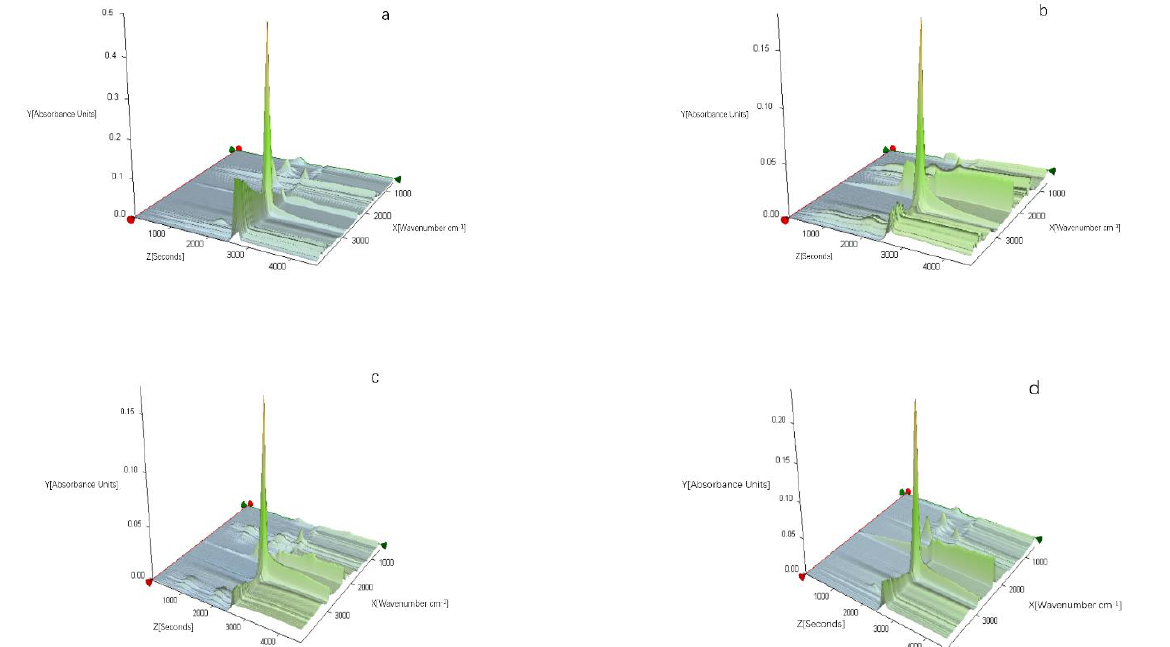
Figure 10. Three-dimensional TG-FTIR spectra of pyrolysis products of: ( a ) EVA, ( b ) EFMgO, ( c , d ) ELDH-1 and ELDH-2 samples during thermal